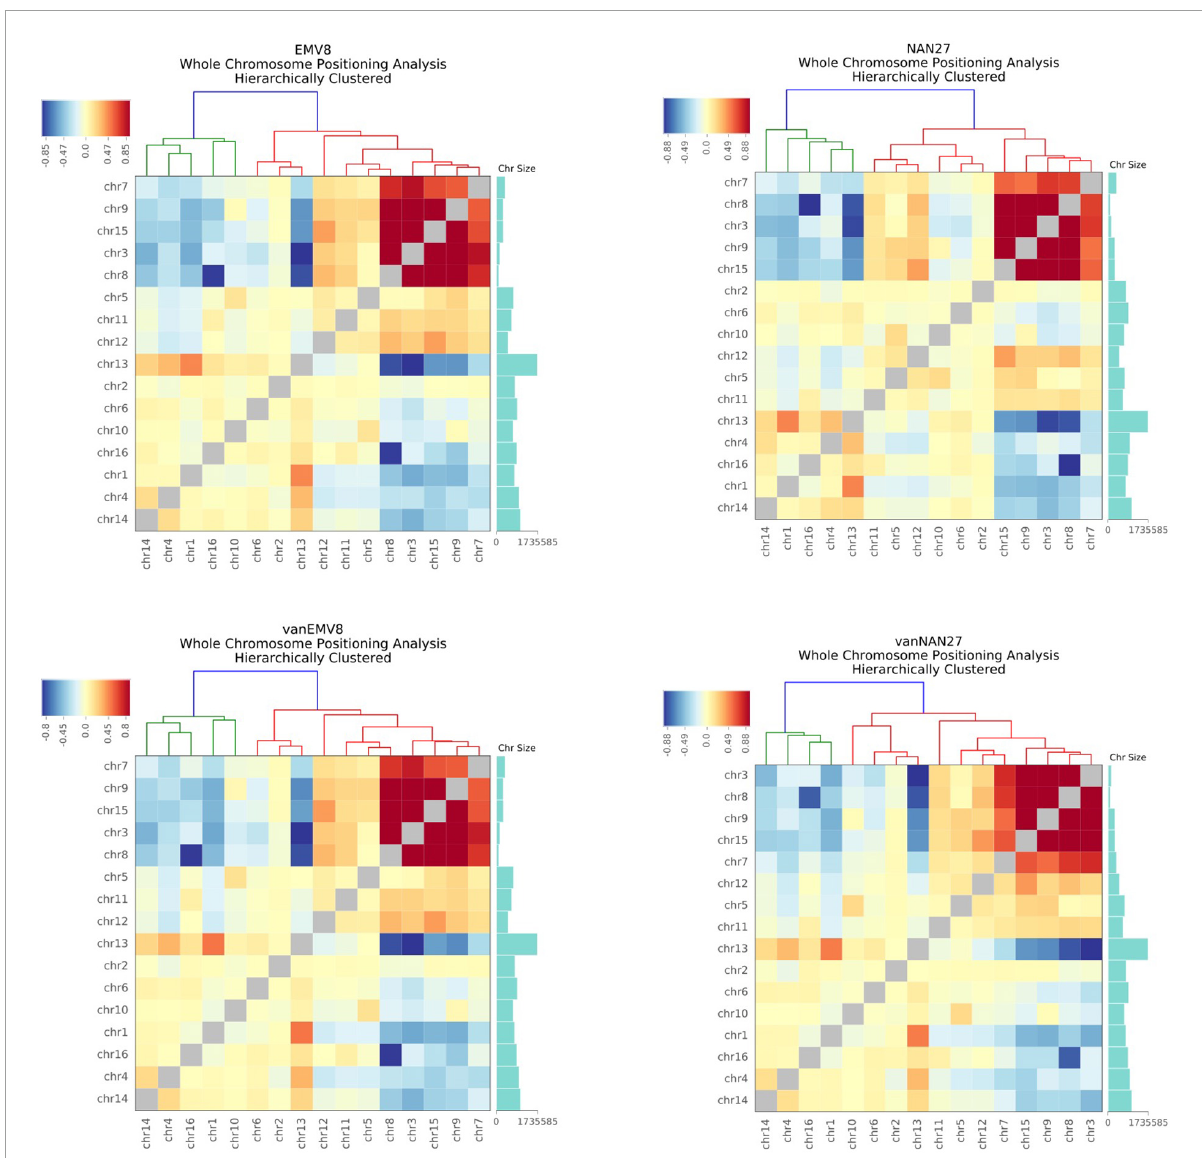
FIGURE2 The heat map of the observed/expected number of contacts between all pairs of whole chromosomes in EMV-8 and NAN-27 with or without vanillin stress. Chromosome sizes were annotated, and hierarchical clustering was performed on the X-axis and Y-axis dimensions according to the interaction values between chromosomes. The long chromosomes tend to interact with the long chromosomes, and the short chromosomes tend to interact with the short